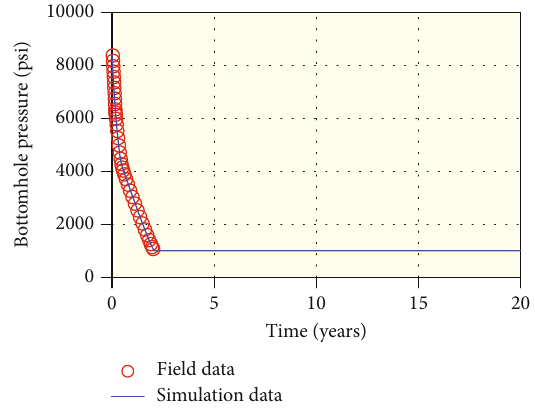
Figure 9: Bottomhole pressure change as the simulation constraint for all